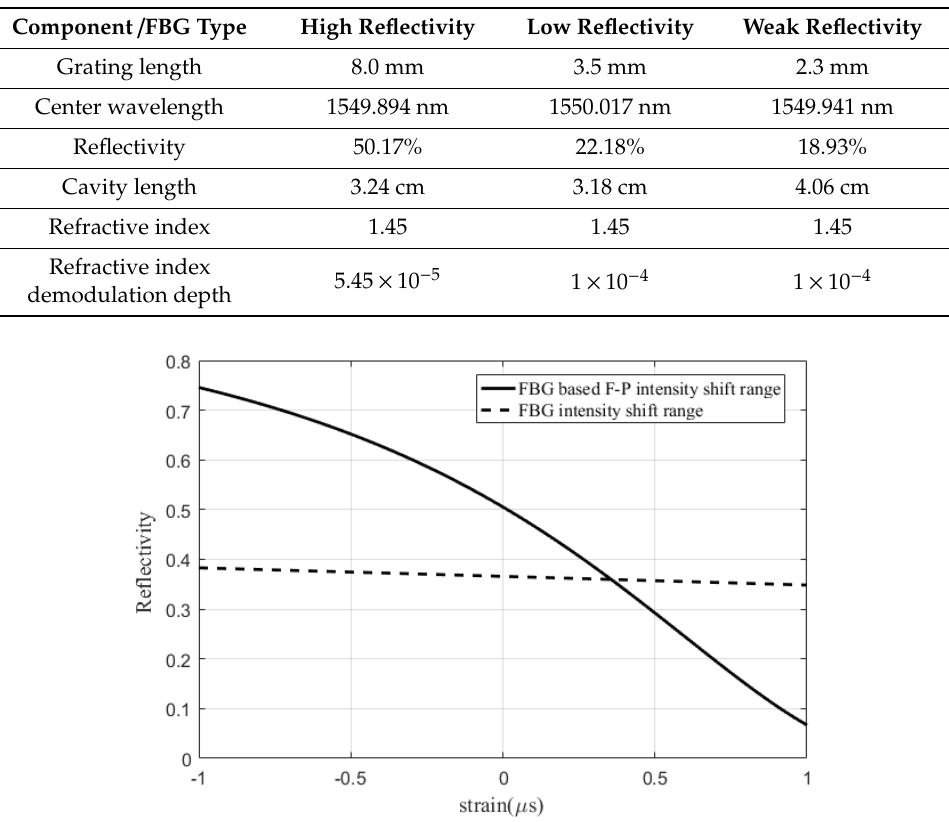
Figure 9. Sensitivity comparison between FBG-based FP sensor and FBG subjected to a micro strain.